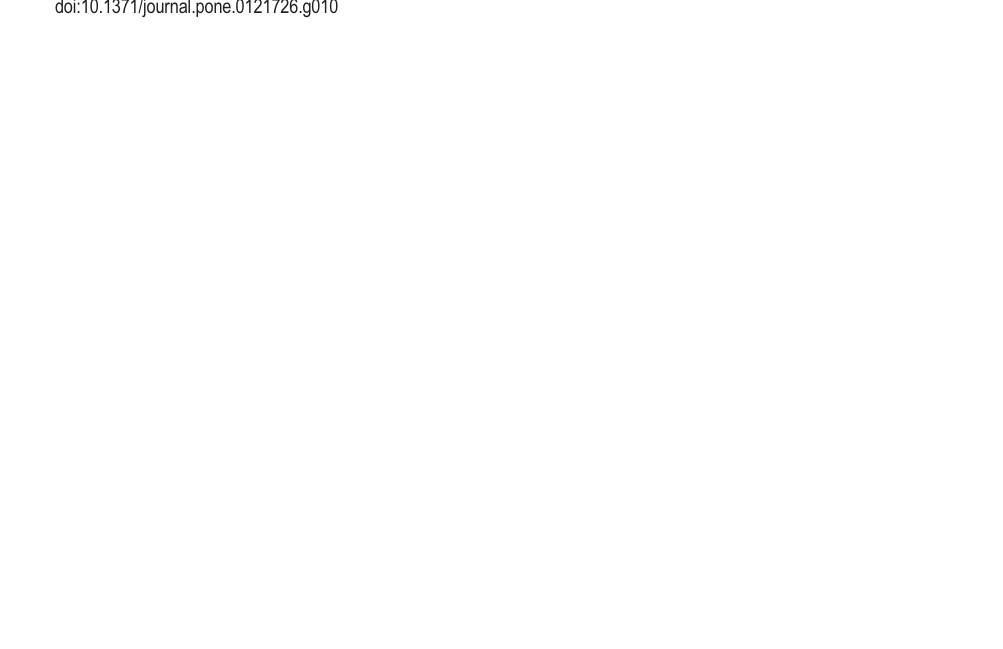
Fig 10. Simulation of a half-sarcomere experiencing a 30 Hz length oscillation. The simulation is described in detail in the text, and the parameters used are found in Table 1. (a) Force-response time-trace of the half-sarcomere. (b) Percent of strongly bound cross-bridges (i.e. in one of the attached states) as a function of